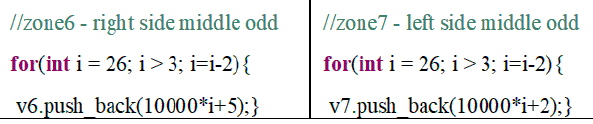
Figure 15. Optimal strategy seat number generation.